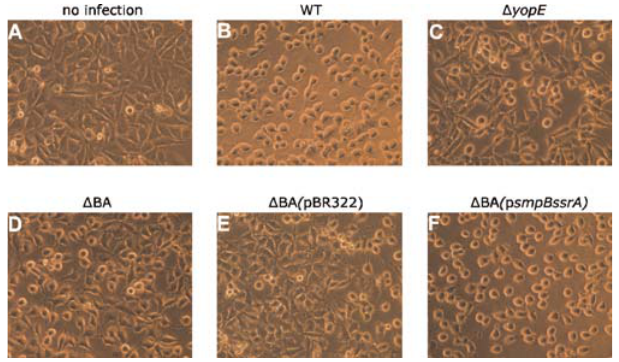
Figure 5. The D BA Mutant Shows Delayed Host Cell Cytotoxicity HeLa cells (A) were infected at an MOI of 20 with wild-type Y. pseudotuberculosis (B), D yopE strain used as a control (C), the D BA mutant (D), and the mutant strain complemented with the p smpBssrA plasmid (E) or control plasmid (F). Morphology of the infected HeLa cells was monitored at 30-min intervals under a phase-contrast microscope. Images were captured 2.5-h post infection.